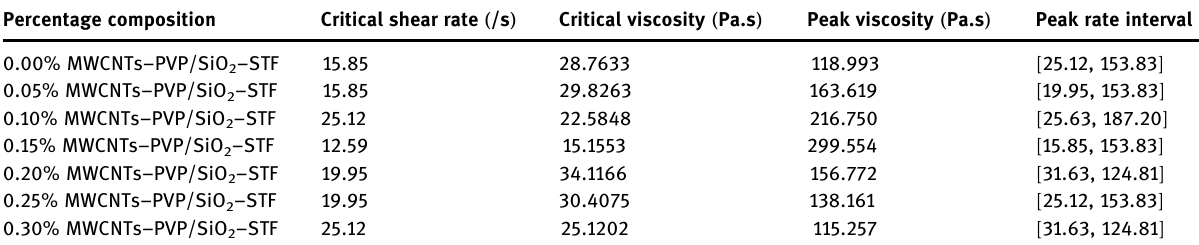
Table 1: The rheological characteristic parameters of the MWCNTs – PVP/SiO 2 – STF system with di ff erent mass fractions of PVP Percentage composition Critical shear rate ( /s ) Critical viscosity ( Pa.s ) Peak viscosity ( Pa.s